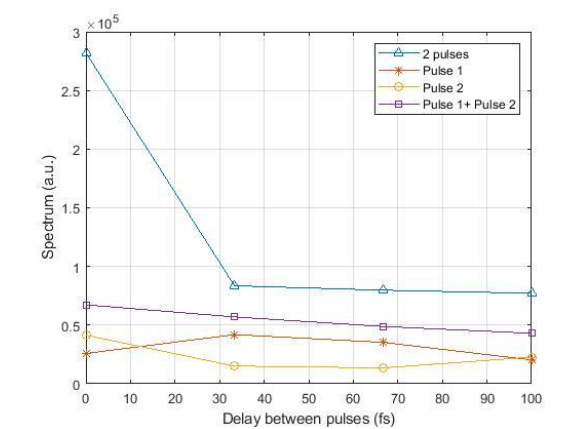
Fig. 2. Measurements of integrated spectrums with SA.